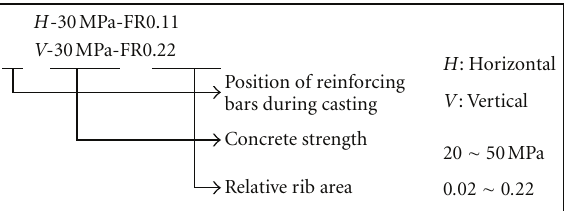
Figure 5: Key to specimen numbering